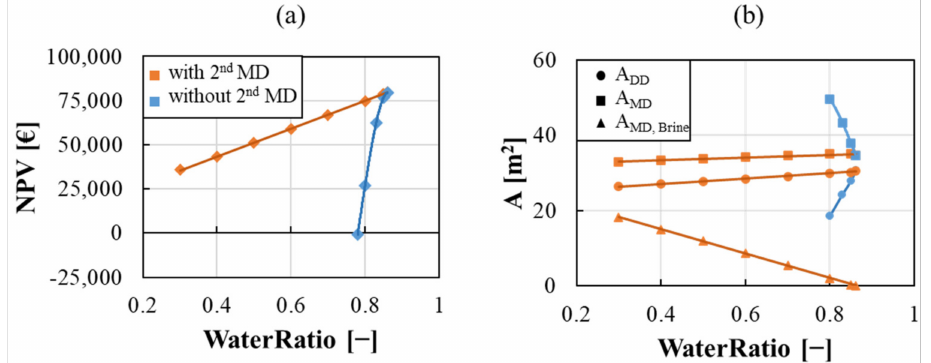
Figure 6. Pareto frontier ( a ) and optimal value of the total membrane area ( b ) vs. WaterRatio for the scenario with (orange) and without (blue) the MD unit for outlet brine treatment.